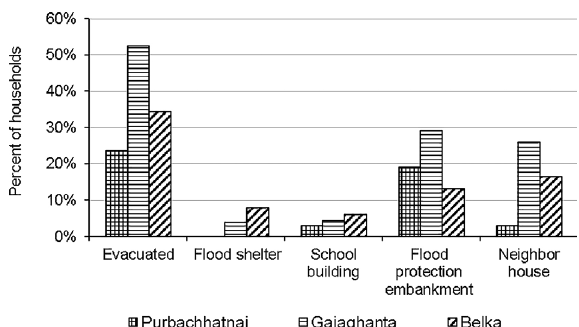
Fig. 2. Evacuation centres (multiple responses considered) reported by the households (n = 377, year